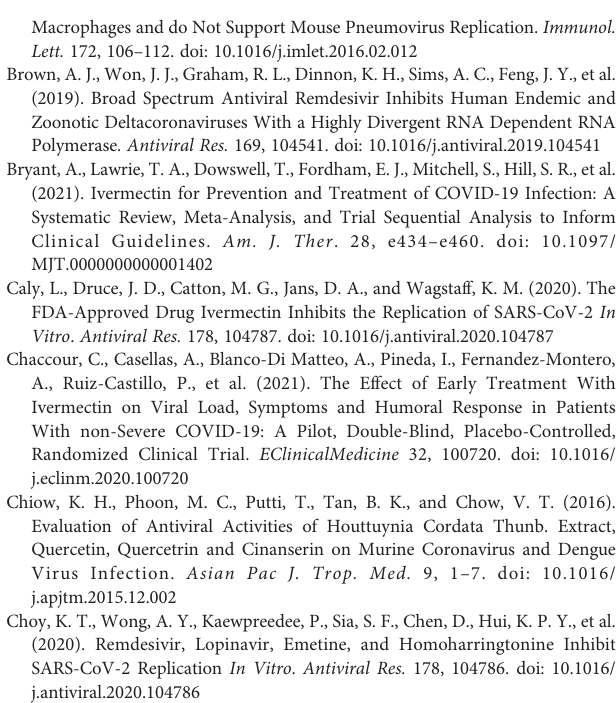
Supplementary Figure 1 | The drug cytotoxicity pro fi les of H2.35 murine liver cells, and dose-response curves of MHV-infected H2.35 cells. (A) Cytotoxicity pro fi les of remdesivir and chloroquine on H2.35 cells as measured by MTS assay after 48 hours exposure. Percentage of cell viability was normalized to untreated cells and blank control. Experiments were performed in quadruplicates. (B) Viral inhibitory activities of remdesivir and chloroquine against MHV infection of H2.35 cells. Live coronavirus titers (pfu/ml) were quanti fi ed by plaque assays performed in triplicates. The dose-response curves were fi tted using the non-linear regression method, and IC50 values were calculated using the Prism 7 software. Error bars represent standard error of the mean (SEM). (C) Mean values of CC50, IC50 and selectivity index (SI = CC50/EC50) of remdesivir and chloroquine treatment of H2.35 cells. Supplementary Figure 2 | Representative morphological features of RAW264.7 macrophages under different infection and/or treatment conditions. Microscopic images were captured by the EVOS XL microscope at 10× magni fi cation. The scale bar represents 200 m m. (A) Uninfected control cells. (B) MHV-infected control cells. Monotherapy of MHV-infected macrophages using: (C) remdesivir alone, (D) chloroquine alone, (E) ivermectin alone, (F) doxycycline alone. Combination therapy of MHV-infected macrophages using: (G) remdesivir and chloroquine, (H) remdesivir and ivermectin, (J) remdesivir and